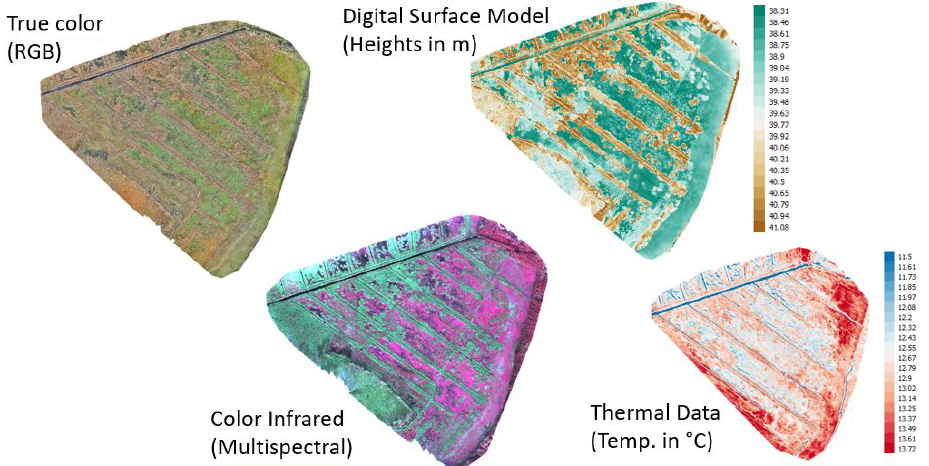
Figure A1. True-color, multispectral (band combination: near infrared–red–green), digital surface model and thermal orthomosaic of the multisensor UAS data.